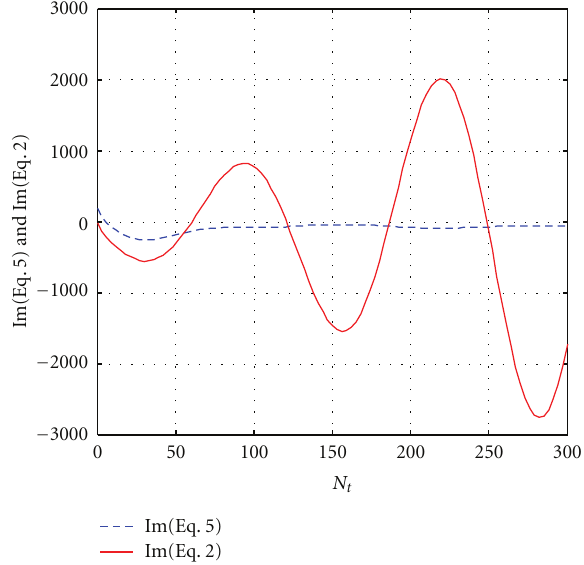
Figure 3: Comparison of (cid:2) G E and